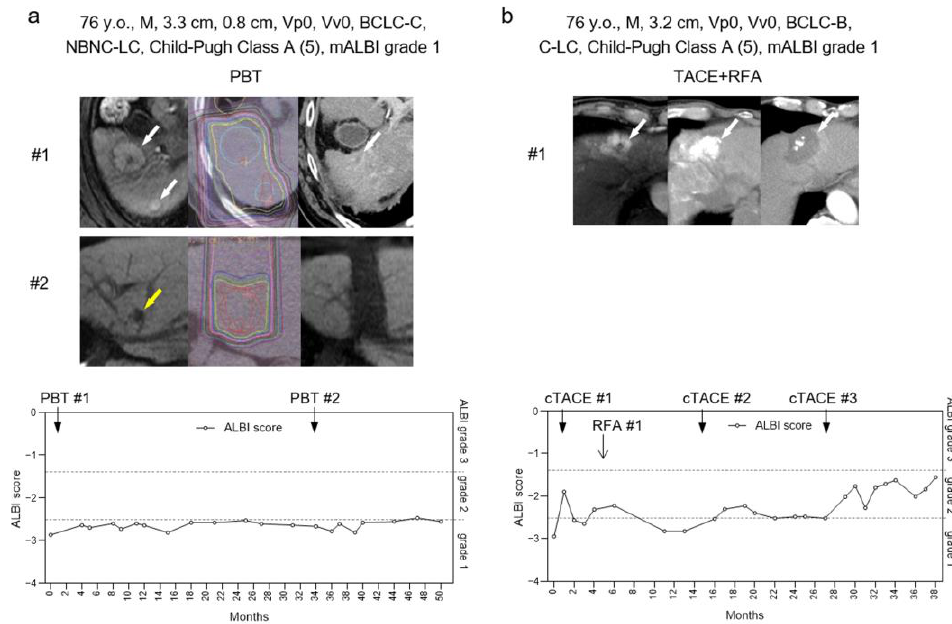
Figure 1. Clinical course of two representative cases treated with PBT or TACE + RFA for HCC. ( a ) Imaging studies of one case of PBT for HCC ( #1 ; white arrow, #2 ; yellow arrow) ( #1 left : EOB-MRI arterial phase before treatment, middle : PBT dose distribution, right : contrast CT scan delayed phase 40 months after PBT, #2 left : EOB-MRI hepatocellular phase before treatment, middle : PBT dose distribution, right : EOB-MRI hepatocellular phase 13 months after PBT), and the course of ALBI score after treatment. ( b ) Imaging studies of one case of TACE + RFA for HCC (white arrow) ( left : pretreatment EOB-MRI arterial phase, middle : simple CT scan after TACE, right : contrast CT scan arterial phase after RFA treatment), and the course of ALBI score after treatment.